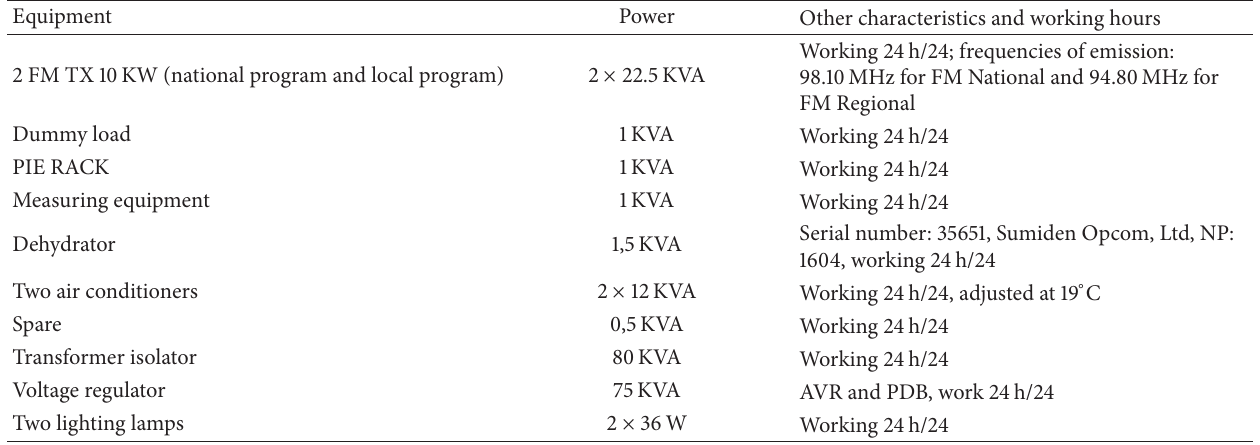
Table 2: Equipment of the FM room.